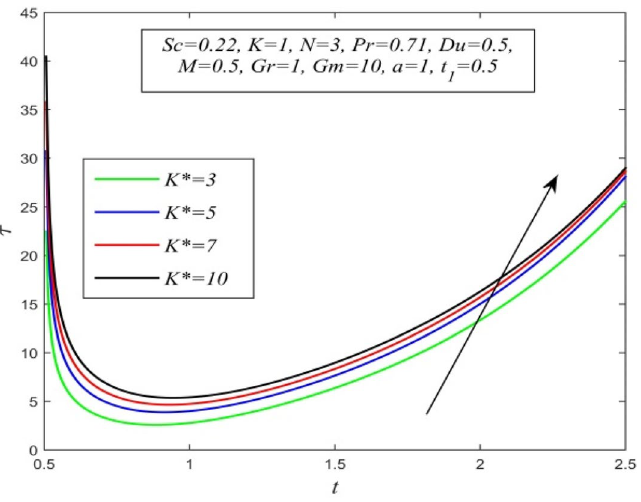
Figure 31. τ versus t for different K* and Sc = 0.22, K = 1, N = 3, Pr = 0.71, Du = 0.5, M = 0.5, Gr = 1, Gm = 10, a = 1, t 1 = 0.5.